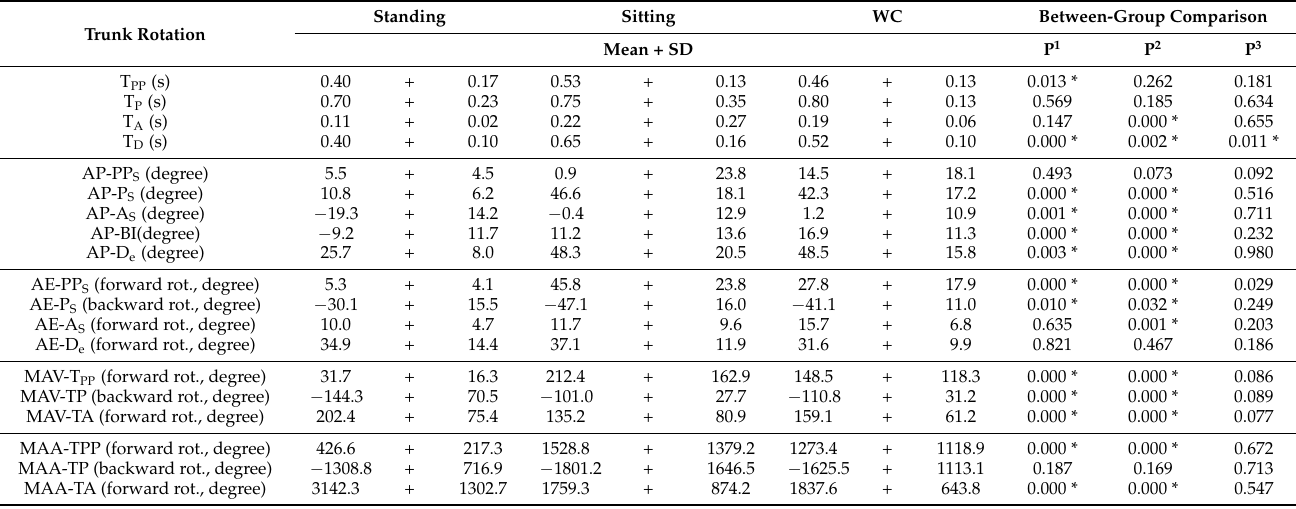
Table 4. Comparison of the time spent, trunk position, angular excursion, maximum angular velocity, and maximum angular acceleration of three different conditions. Trunk